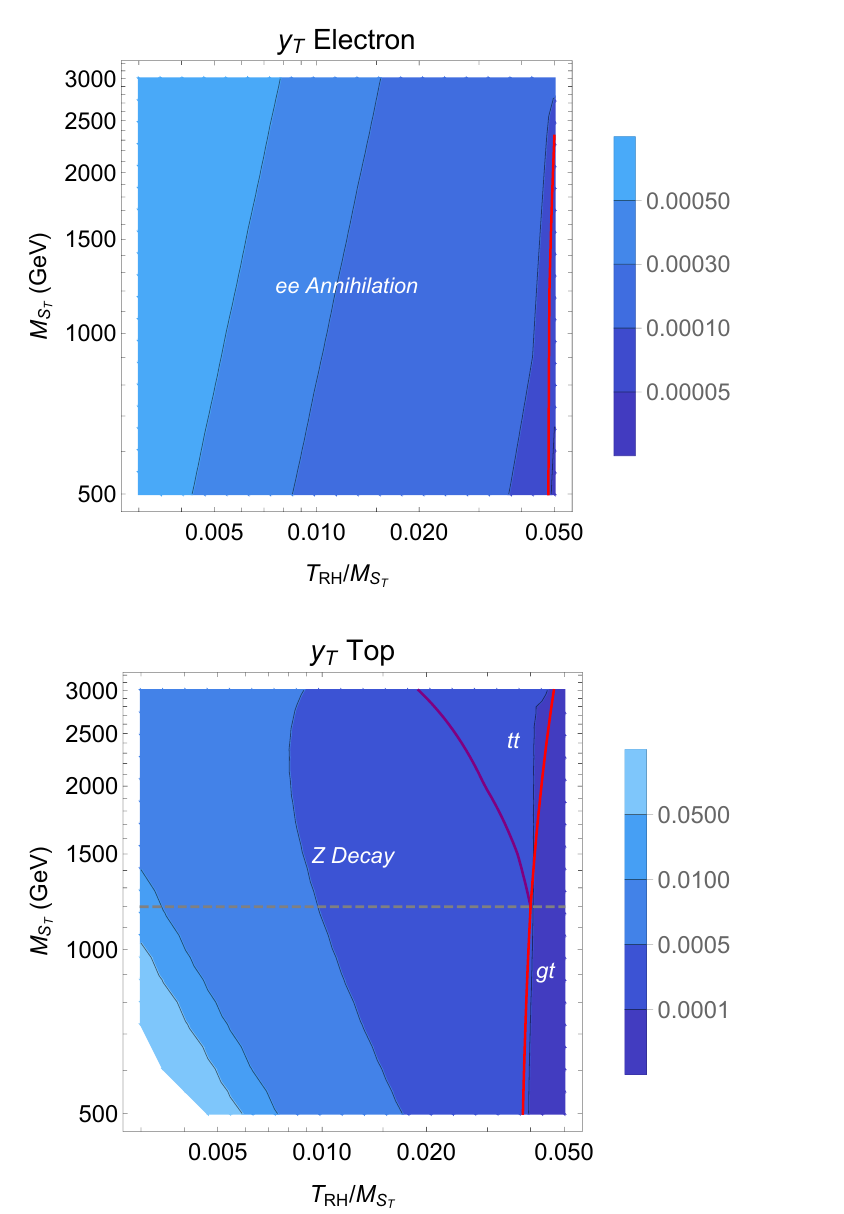
Figure 11 . Contours of the coupling y T needed to produce the correct relic density as a function of the reheat temperature, T RH , and mediator mass, m S , for m X = 1 GeV, for scenarios where the T mediator couples to the right-handed electron (top panel) or the right-handed top quark (bottom panel). Red curves separate regions where different processes dominate dark matter production, as denoted by the labels (see text for more details). The dashed grey curve in the bottom panel denotes the approximate lower bound on m S from the T